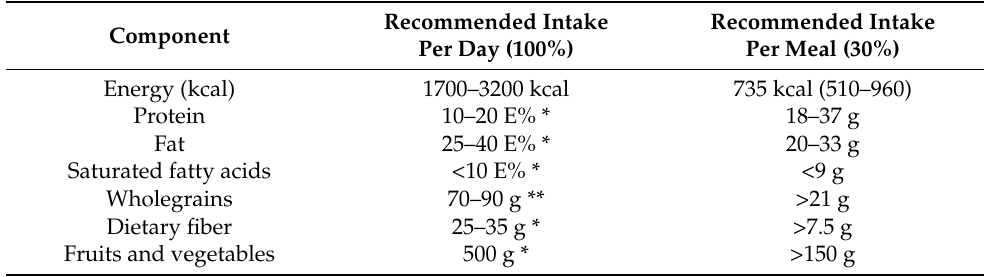
Table 1. Dietary guidelines for a healthy diet, gathered from the Swedish Food Agency [41,42] and the Nordic Council of Ministers [40], with reference values for energy and nutrient content in an average school lunch, corresponding to 30% of the recommended daily intake [43].